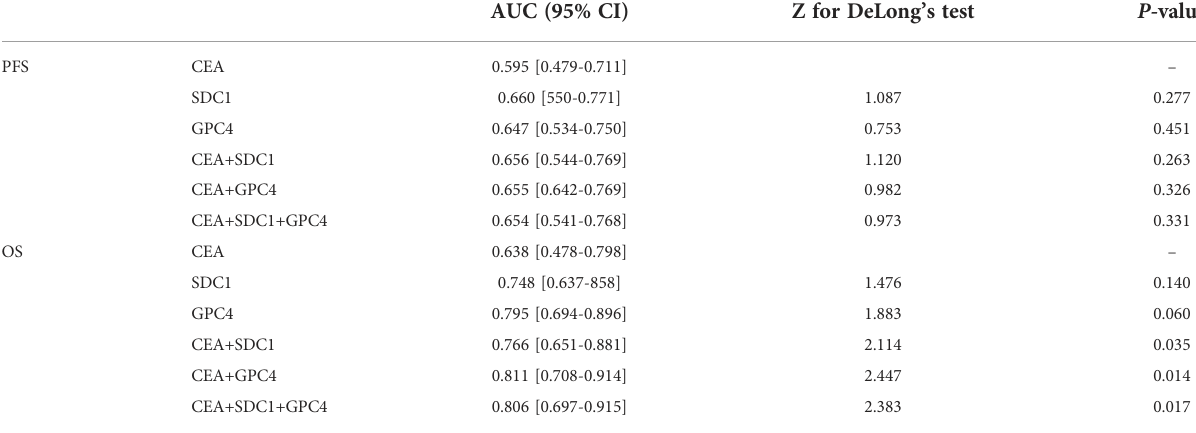
TABLE 2 Results from area under the receiver operating characteristic curve